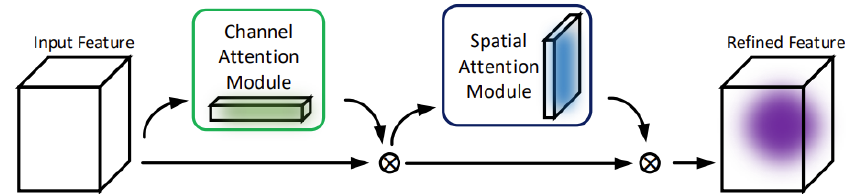
Figure 2. CBAM network structure diagram.